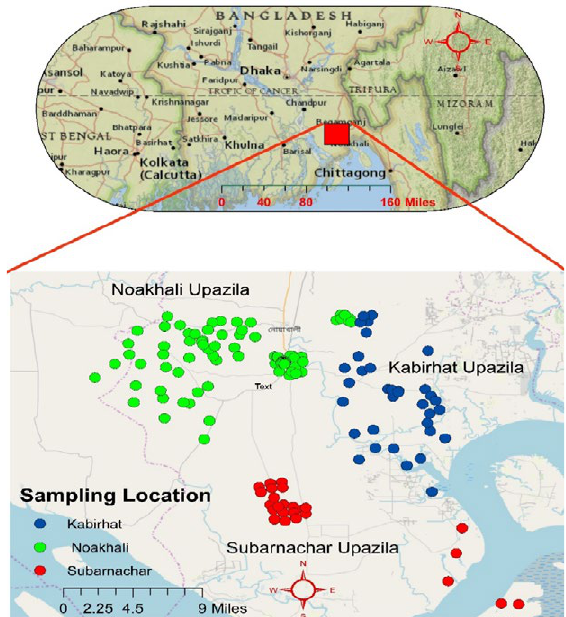
Fig. 1: Geographic locations of the study area along with the sampling site in Noakhali District, Bangladesh Table 1: Site History and features of soil in three different Upazila